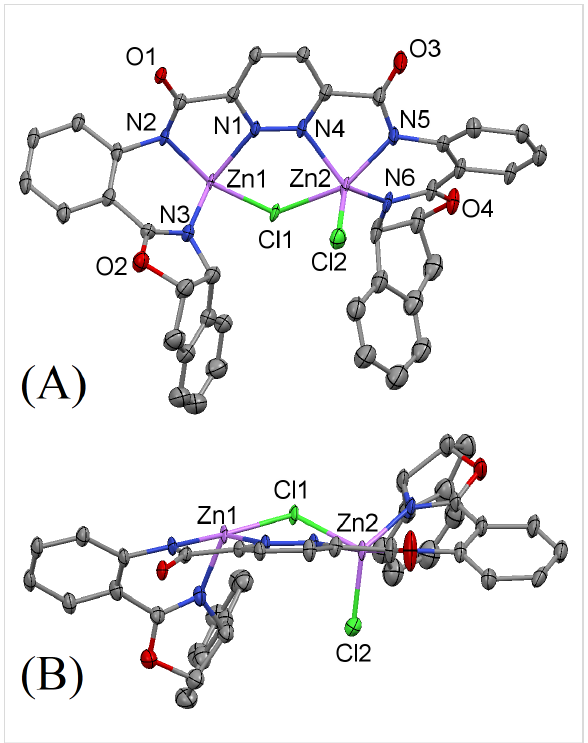
Figure 6: Thermal ellipsoid plot (50% probability) of the molecular structure of 32 ·Zn 2 Cl 2 . Hydrogen and solvate atoms have been omitted for clarity: (A) view normal to the mean molecular plane; (B) side view nearly perpendicular to (A) to allow better view of the region of open access to the metal site. The complex 32 ·Zn 2 Cl 2 crys- tallizes in the monoclinic space group C 2 with a = 40.820(5) Å, b = 7.4084(9) Å, c = 14.6489(17) Å, α = 90°, β = 108.589(2)°, γ = 90°, V = 4189.8(9) Å 3 , Z = 4, D c = 1.575 mg m − 3 and μ (Mo K α ) = 1.453 mm − 1